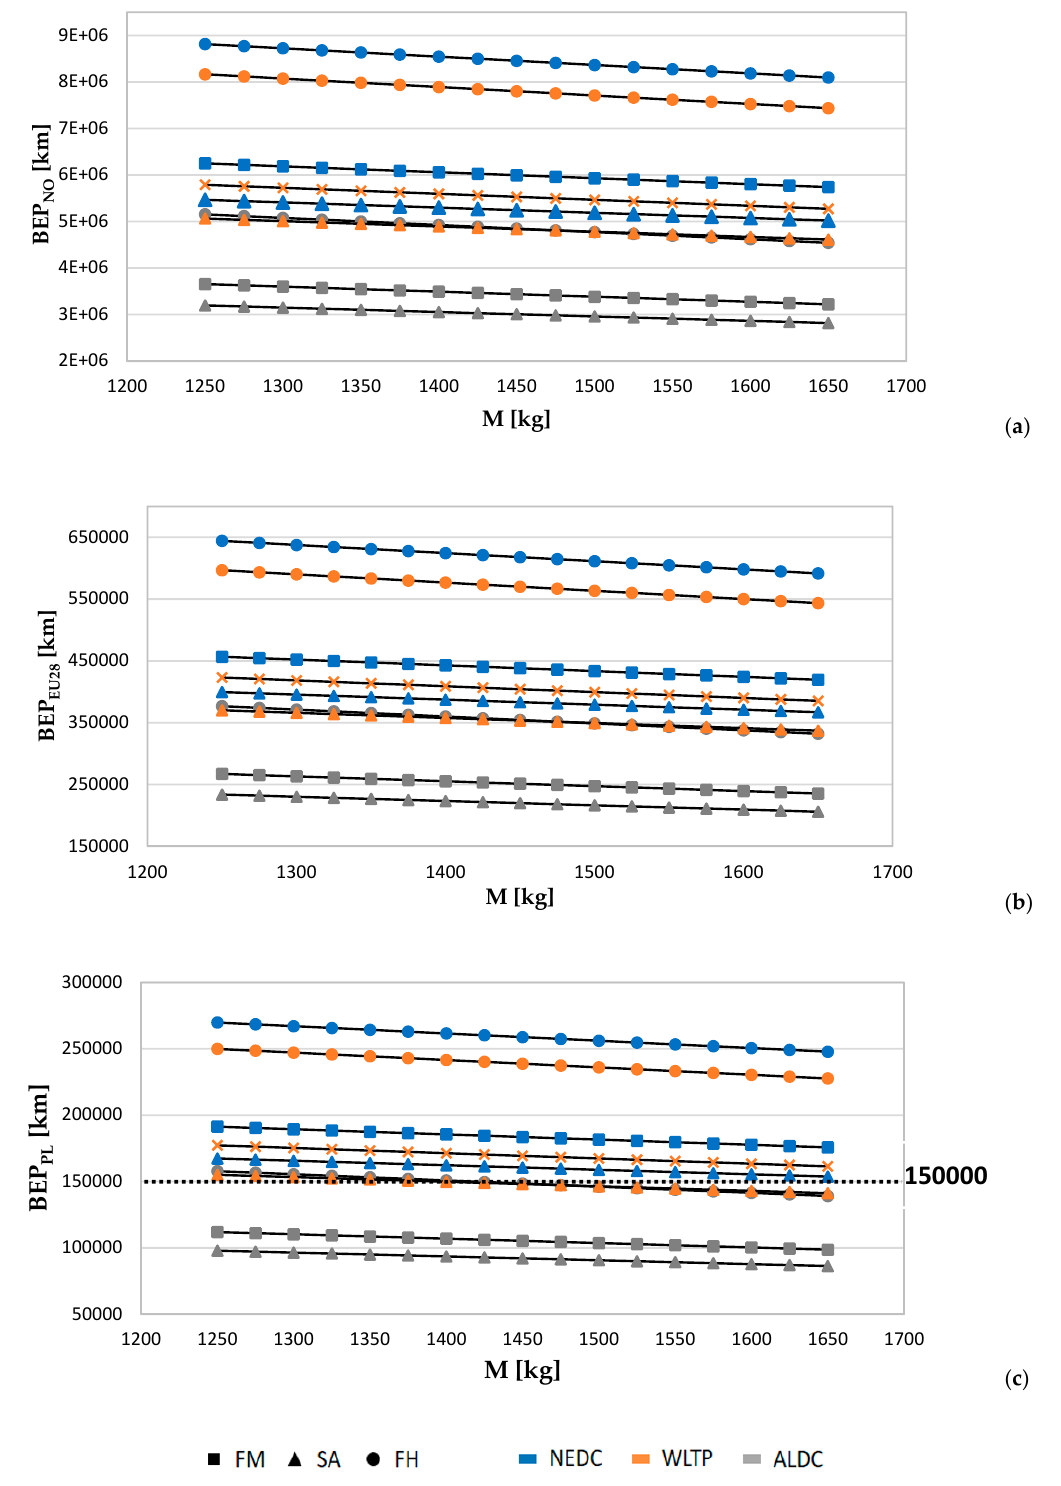
Figure 10. BEP in function of car mass for sustainability case studies FM, FH, and SA. Norwegian grid mix ( a ), average European grid mix ( b ), Polish grid mix ( c ).